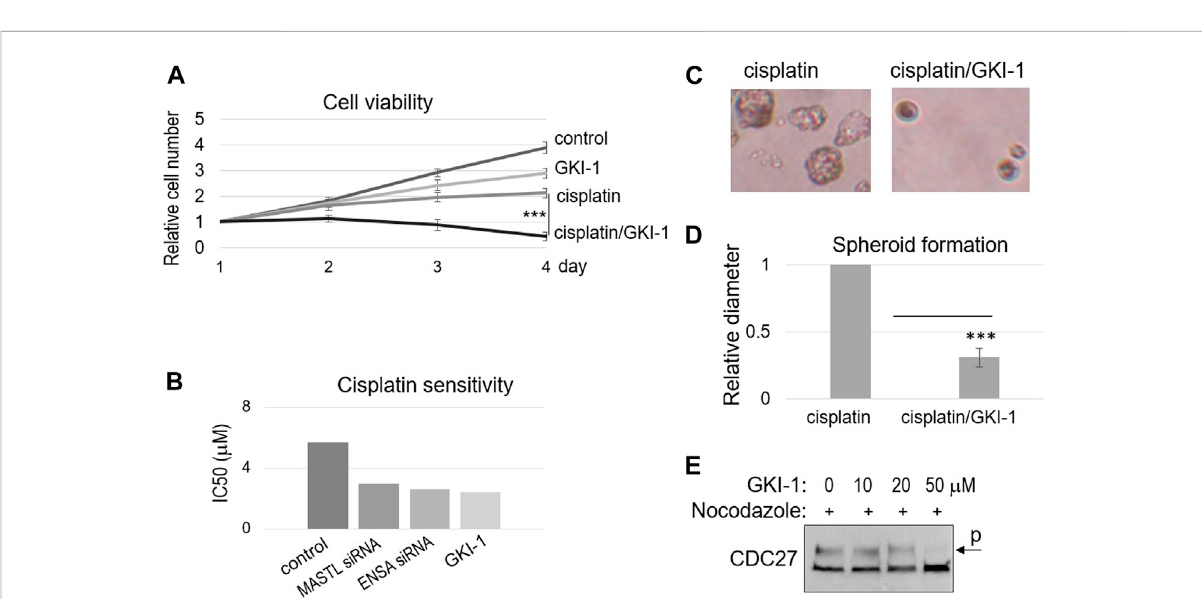
FIGURE 4 GKI-1 sensitizes OSCC cells to cisplatin. (A) SCC38 cells were treated with or without GKI-1 (10 μ M) and cisplatin (3.3 μ M) for 3 days. The cell viability was studied as described in Materials and Methods. The cell numbers at days 2 – 4 were normalized to that at day 1 (untreated). The mean values and standard derivations, from three independent experiments, were shown. (B) SCC38 cells were treated with MASTL siRNA, ENSA siRNA, or GKI-1, as indicated. IC50 of cisplatin was determined, as described in Materials and Methods, and shown. (C,D) SCC38 cells treated with GKI-1 and cisplatin were cultured in soft agar for 14 days. Representative spheroid formation was shown in panel C, and average diameters were shown in panel D (N > 20, p < 0.001). (E) SCC38 cells were treated with nocodazole (1 μ g/ml) for 12 h, so that cells entered mitosis will be arrested/trapped in mitosis.ThecellswerealsotreatedwithvariousconcentrationsofGKI-1,asindicated,topreventmitoticentry.Cellswereharvestedandanalyzedby immunoblotting for CDC27. The phosphorylation of CDC27 retards its gel migration, and is commonly used as a marker of